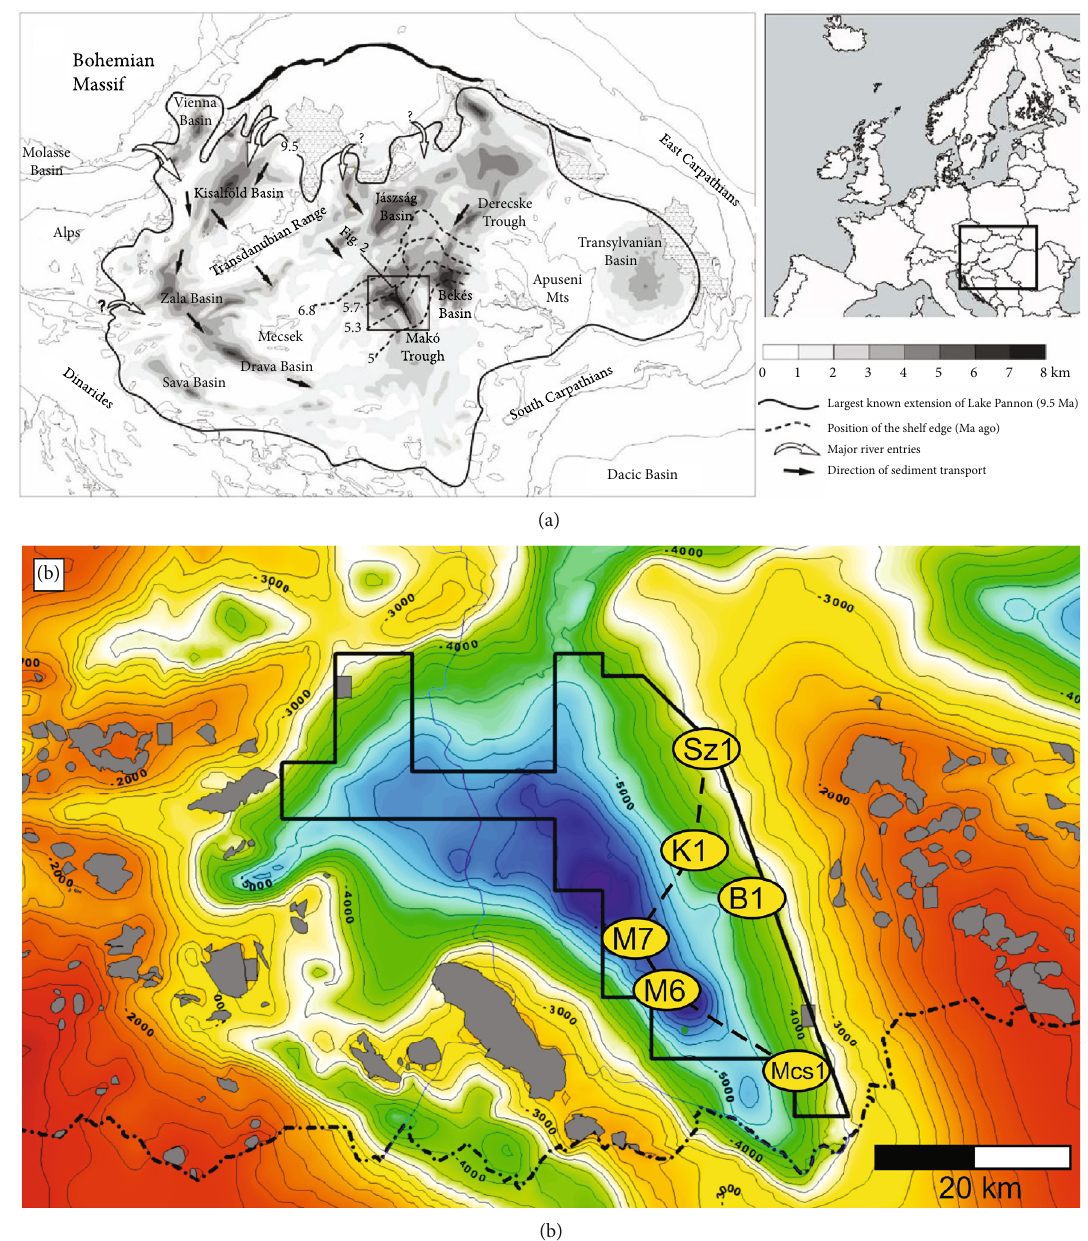
Figure 1: Maps of the studied area. (a) Depth of the Neogene basement of the Pannonian Basin [40]. The thick line indicates the largest known extension of Lake Pannon 9.5 Ma ago, whereas the dashed lines mark the position of the shelf-edge at between 6.8Ma and 5 Ma [30]. White and black arrows indicate major rivers entering the basin and main direction of the sediment transport, respectively [25]. Rectangle shows the location of map on (b). (b) Map of Neogene basement depths and highs with the location of the Makó Trough; the studied wells are marked by yellow [41]. Location of the seismic line (Figure 4) is indicated by a dashed line. Oil and gas fi elds are indicated with green and red colors, respectively. Inset map shows Europe and the location of map (a) (rectangle). Hydrocarbon fi elds are indicated with grey